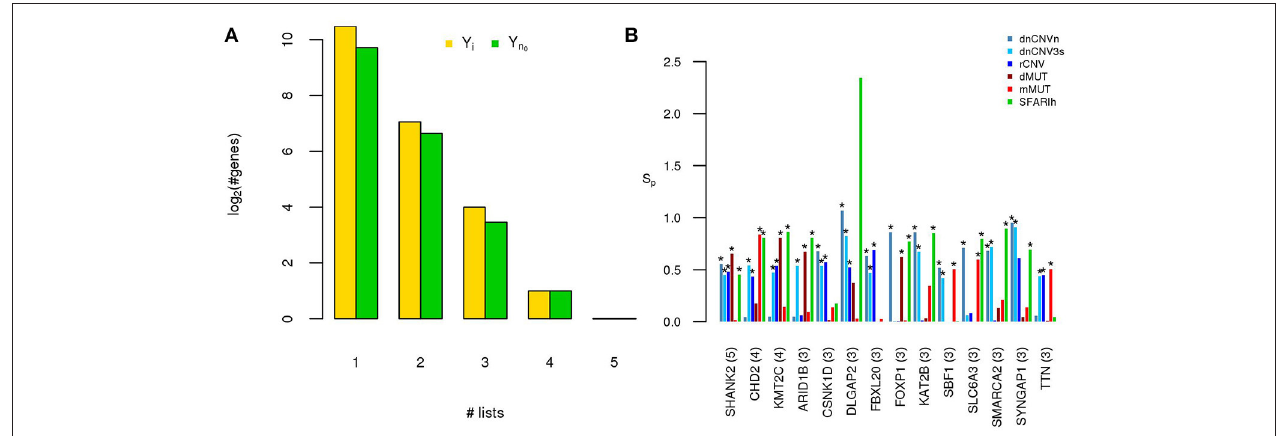
FIGURE 2 | A small number of ASD risk genes is found in more than one large study. (A) Number of risk genes found in 1 or more of the six gene lists on ASD; i : original gene lists; n0 : original gene lists wit only genes occurring in the STRING network. (B) Permutation-adjusted network smoothing index of the 14 genes occurring in 3 or more original lists (the number is reported between parenthesis); the asterisk (*) indicates genes of the corresponding original list.